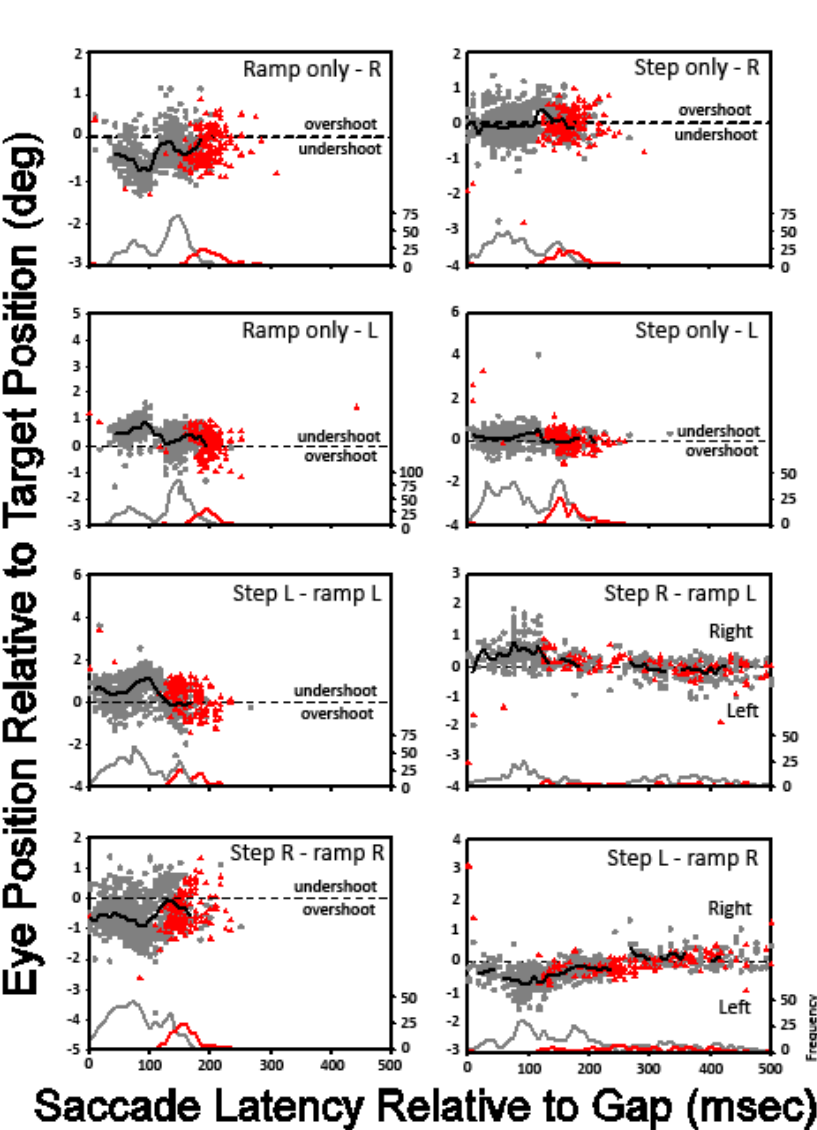
Figure 6 : Post-saccadic eye position relative to target position is plotted against saccade latency relative to the end of the gap. Data for all subjects are combined, with each panel representing a different step-ramp combination. cies. That is, when subjects delayed the onset of their saccades, the resulting saccades were more